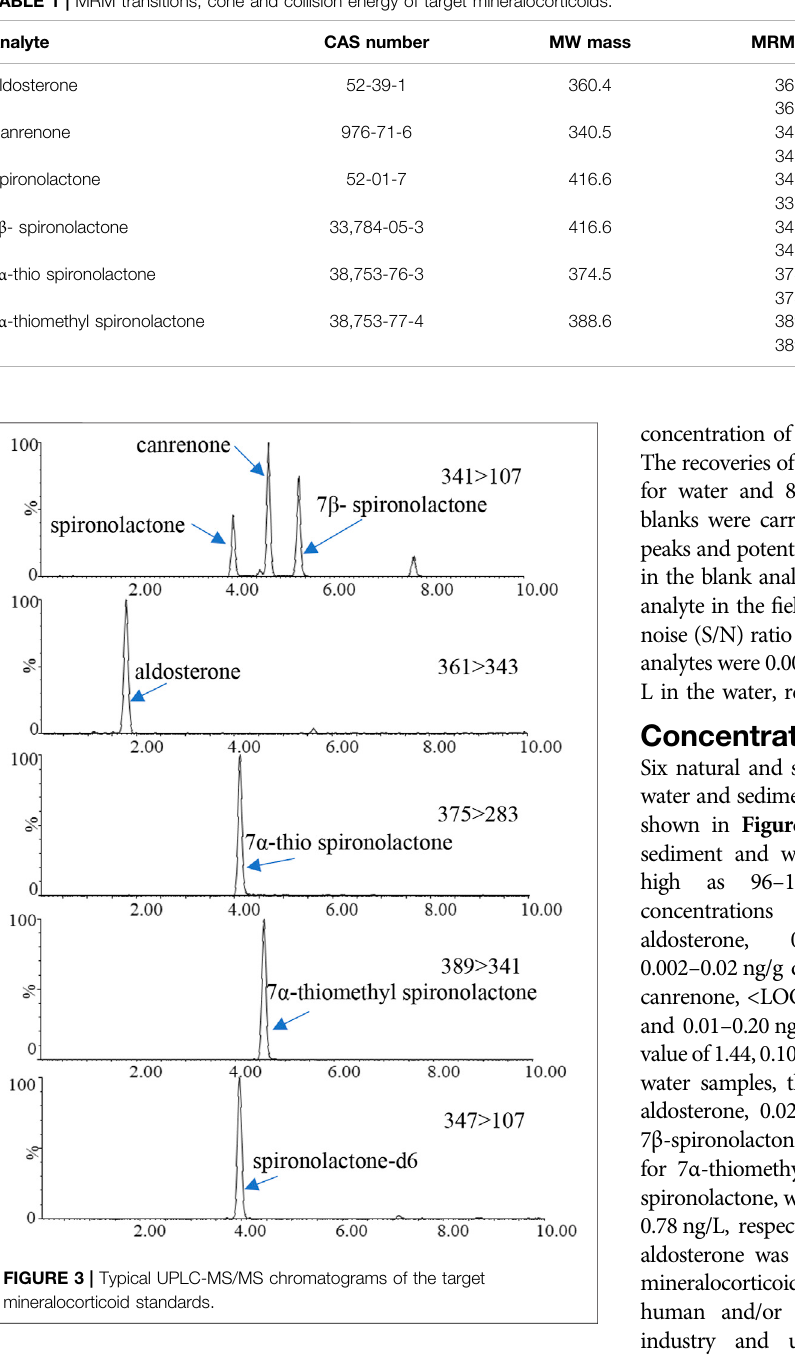
Frontiers in Environmental Science |